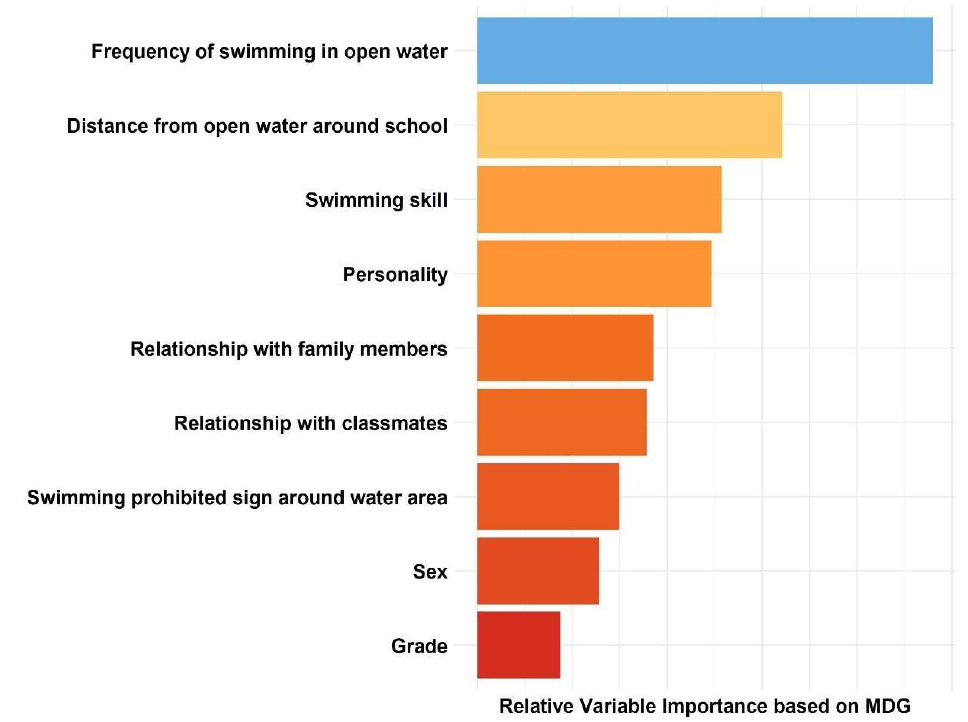
Figure 3. The relative importance of risk factors using a random forest model.